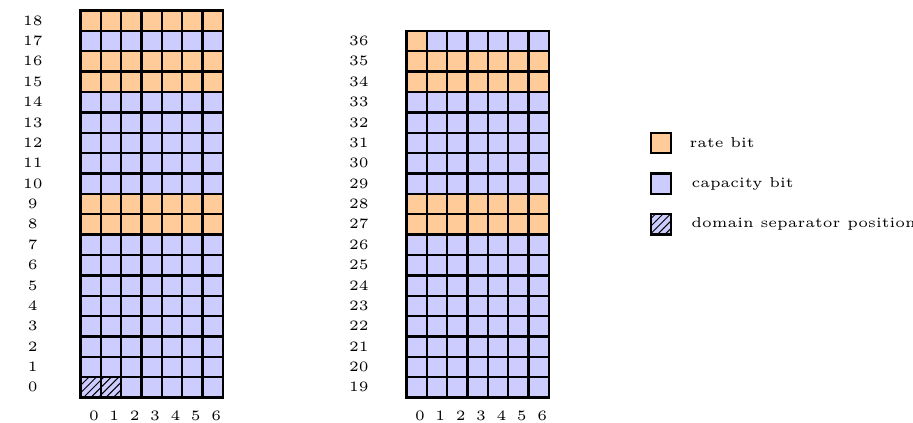
Figure 5: Visualization of internal state of WAGE - AE